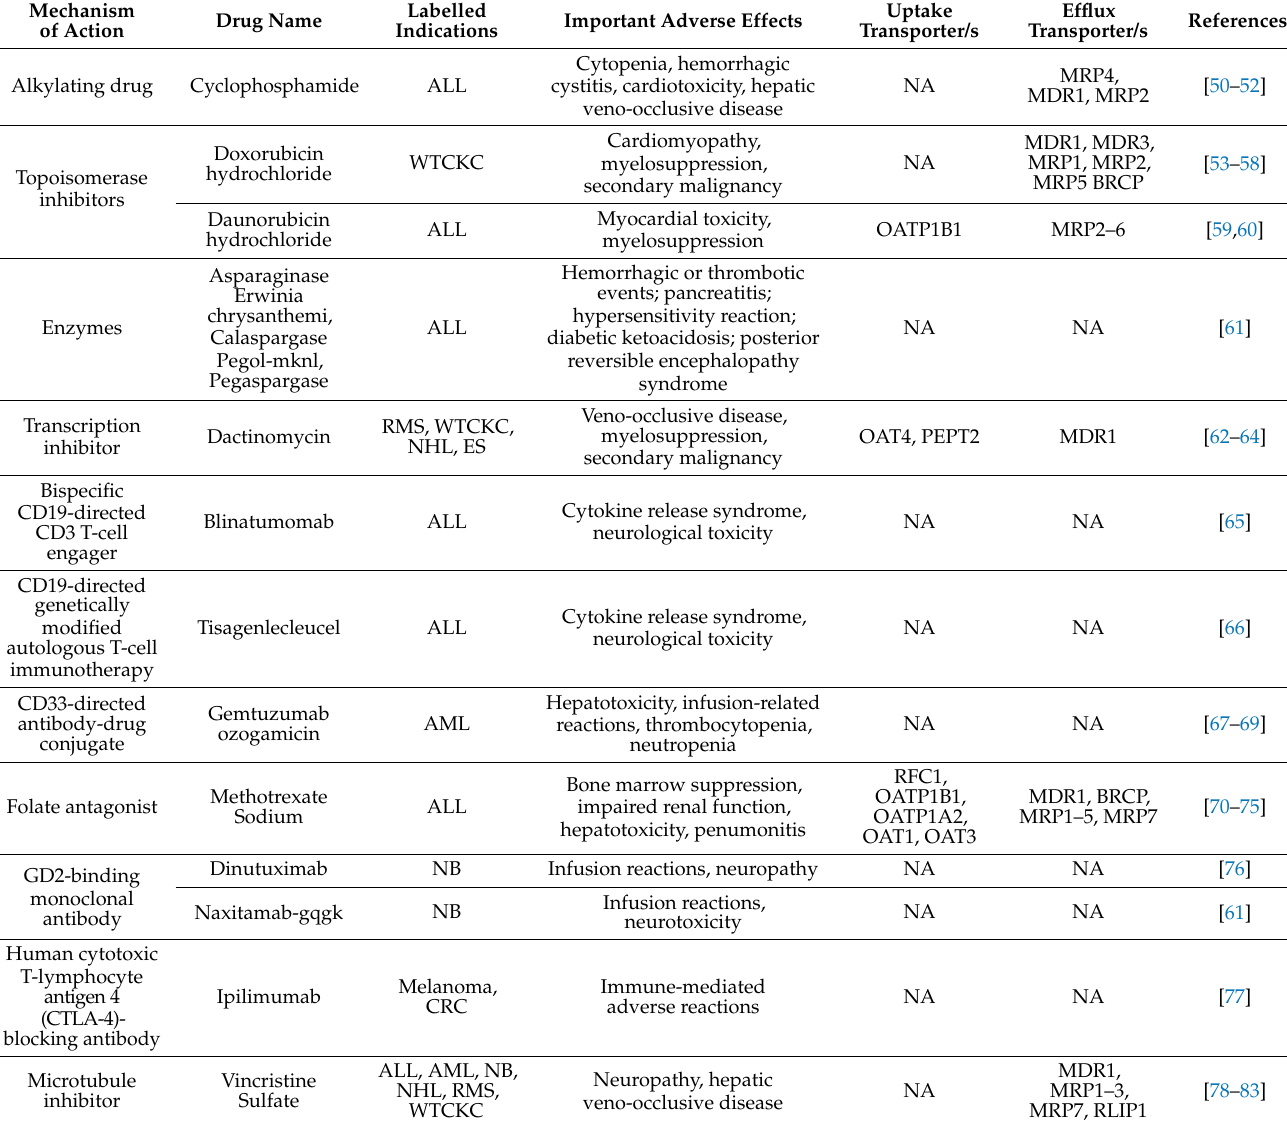
Table 1. The anticancer agents commonly used in pediatric oncology and their drug